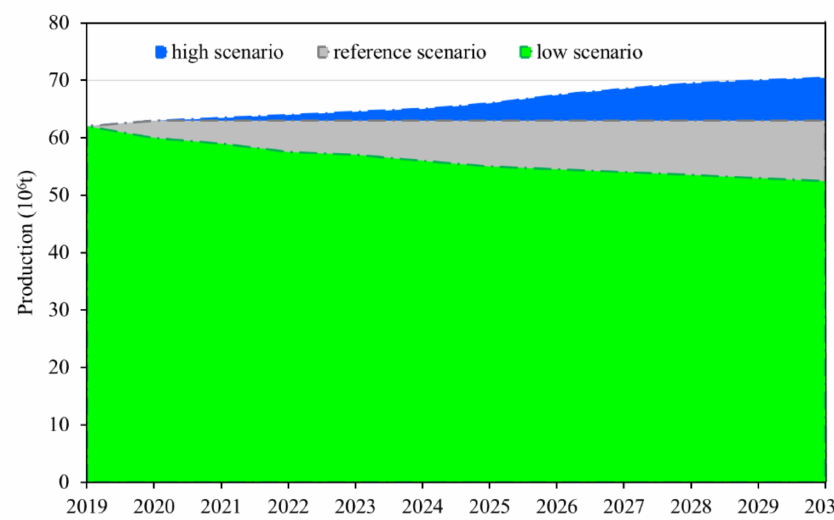
Figure 2. The forecast of hard coal production in Poland, 2019–2030 according to